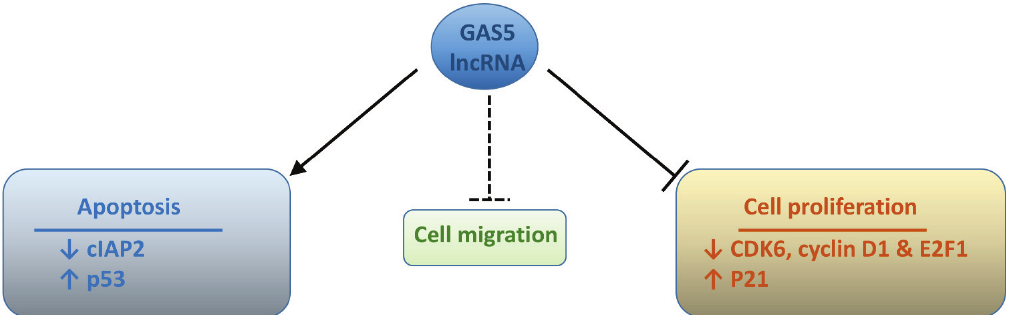
Figure 3. Summary of biological processes that are regulated by GAS5 lncRNA, including possible downstream molecular targets. ↓ and ↑ = down - and up-regulation,